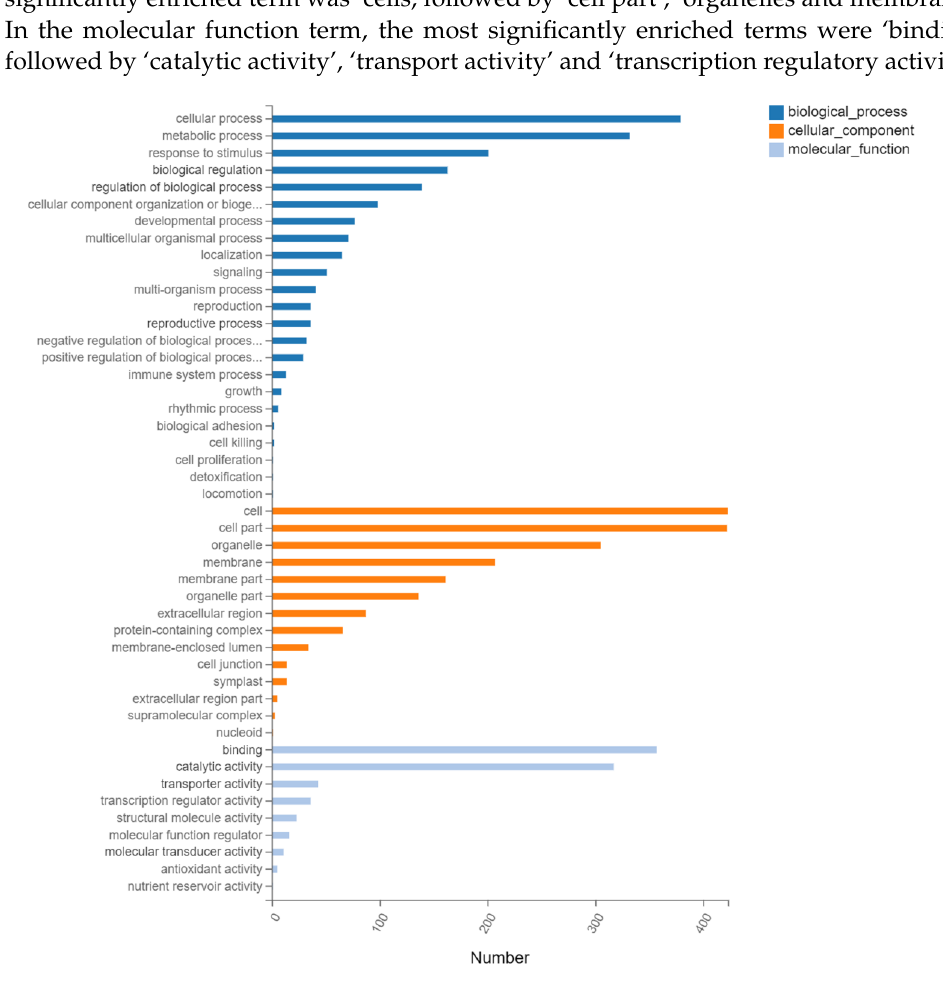
Figure 8. GO classification of differentially expressed genes. Among 110 KEGG pathways of N12-vs.-NE12, 15 pathways were significantly en- riched, with corrected p value ≤ 0.05 (Figure 9). DEGs were significantly enriched in pho- tosynthetic antenna protein, alanine, aspartate and glutamate metabolism, and protein processing in endoplasmic reticulum. In addition, it was also enriched in ‘plant hormone signal transduction’, ‘glycolysis/gluconeogenesis’ and ‘starch and glucose metabolism’.